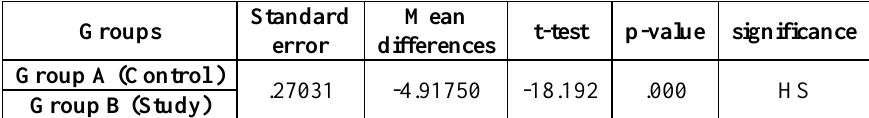
Table 7: Descriptive parameters of surface roughness test um